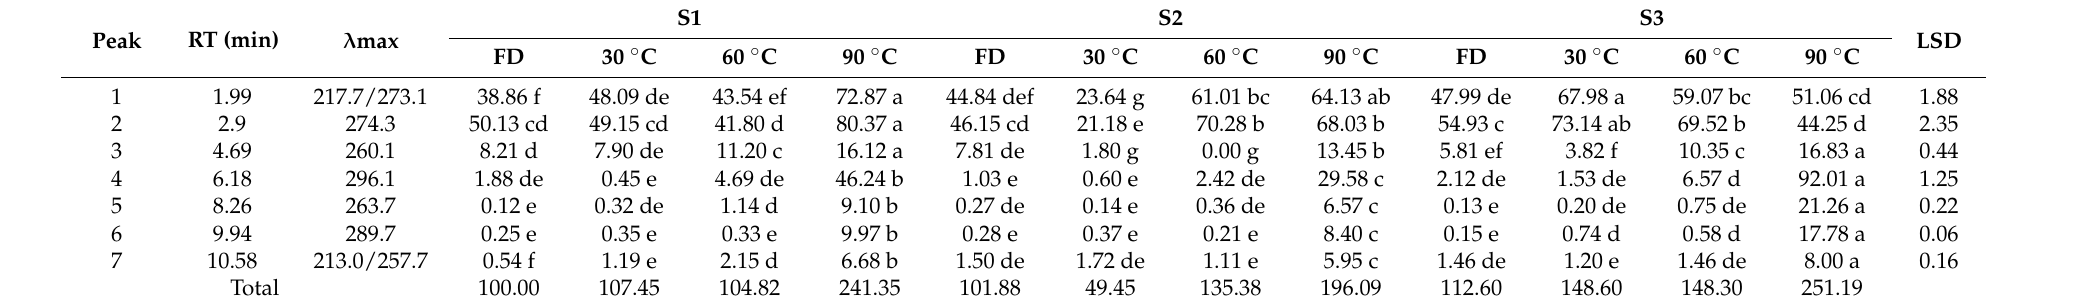
Table 1. The change in the content (%) of seven candidate phenolic compounds according to the drying temperature of fruits.